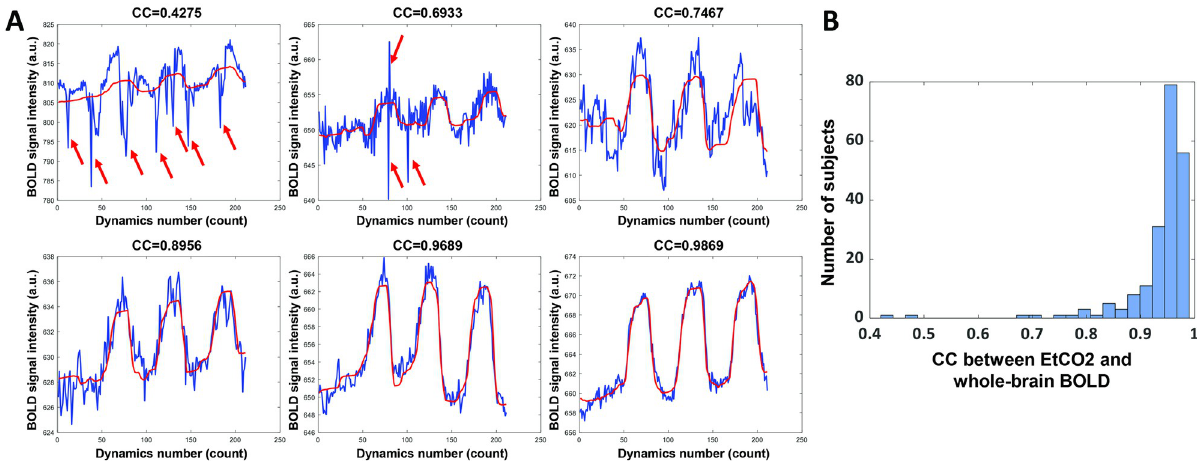
Fig 7. Performance of the temperal alignment between EtCO2 and BOLD time courses. (A) Examples of the optimally shifted EtCO2 curves with the corresponding whole-brain BOLD time courses. Six examples with ascending data quality are shown. Red arrows indicate BOLD signal spikes due to subject motion, which result in lower correlation coefficients (CC) between EtCO2 and whole-brain BOLD time courses. (B) Histogram of the CC in 203 healthy subjects.